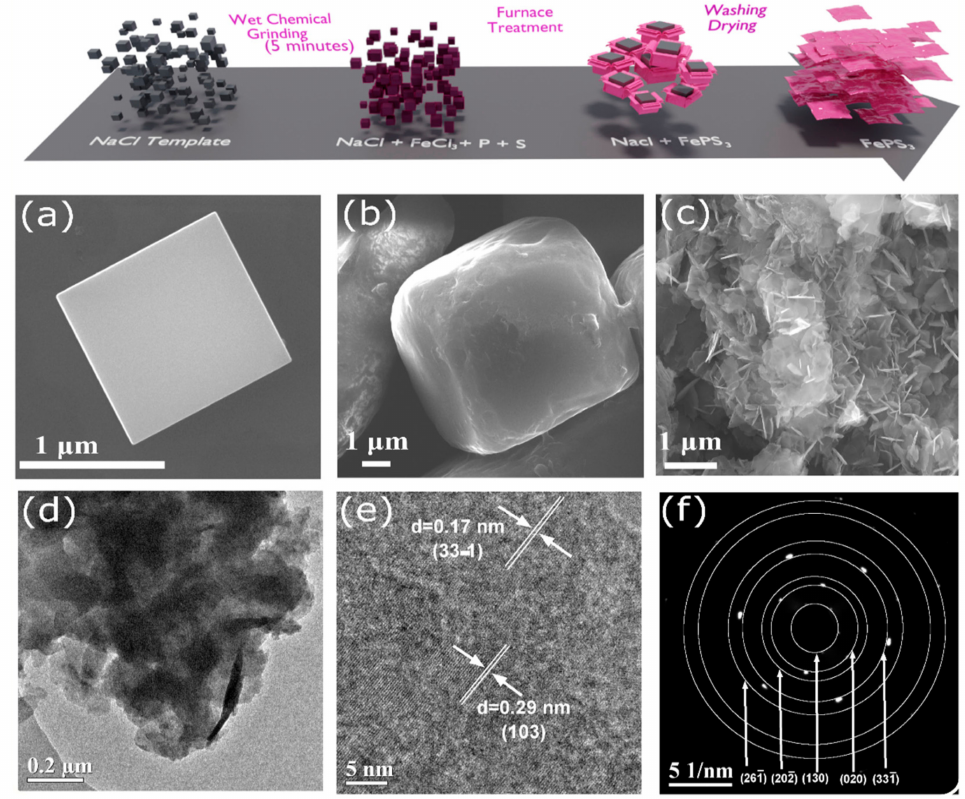
Figure 1. Schematization of the synthesis strategy of FePS 3 via the salt-template method. SEM images of ( a ) NaCl template ( b ) FeCl 3 , sulfur, and phosphorus-coated NaCl and ( c ) FePS 3 nanoflakes. ( d ) TEM image of FePS 3 nanoflakes; ( e ) HRTEM image of a representative FePS 3 . The well-defined interlayer spacing of 0.17 and 0.29 nm indicates the presence of crystalline FePS 3 . ( f ) Selected area electron diffraction (SAED) pattern of FePS 3